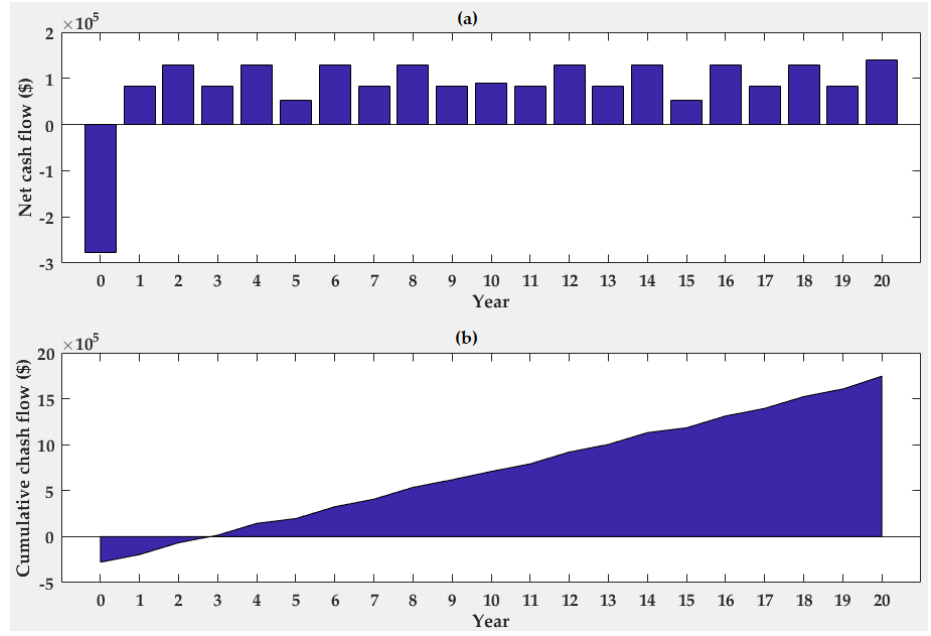
Figure 13. Net cash flow diagram ( a ) and cumulative cash flow ( b ) of the hypothetical project.